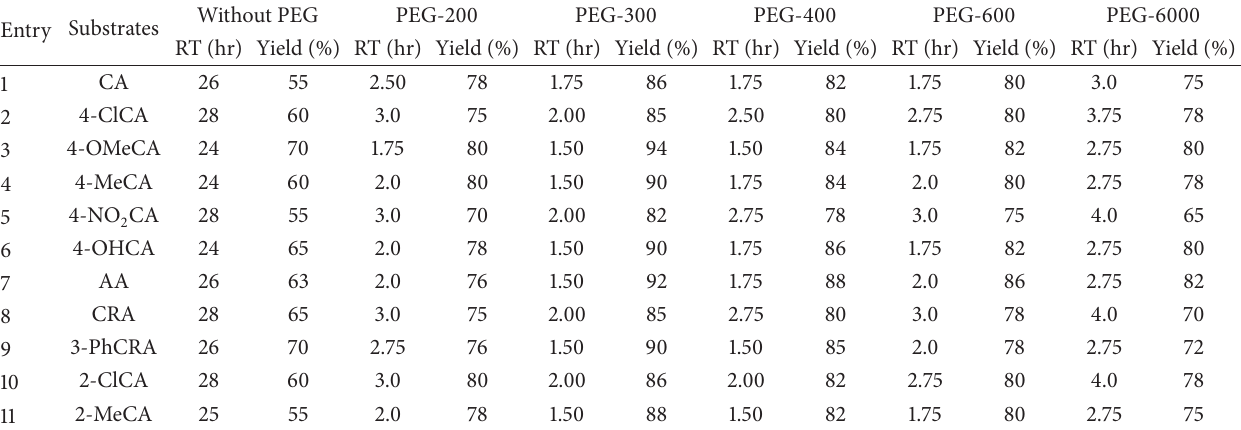
Table 1: Effect of different PEGs on Fe (III)-Phen triggered nitro Hunsdiecker reactions with unsaturated carboxylic acids.